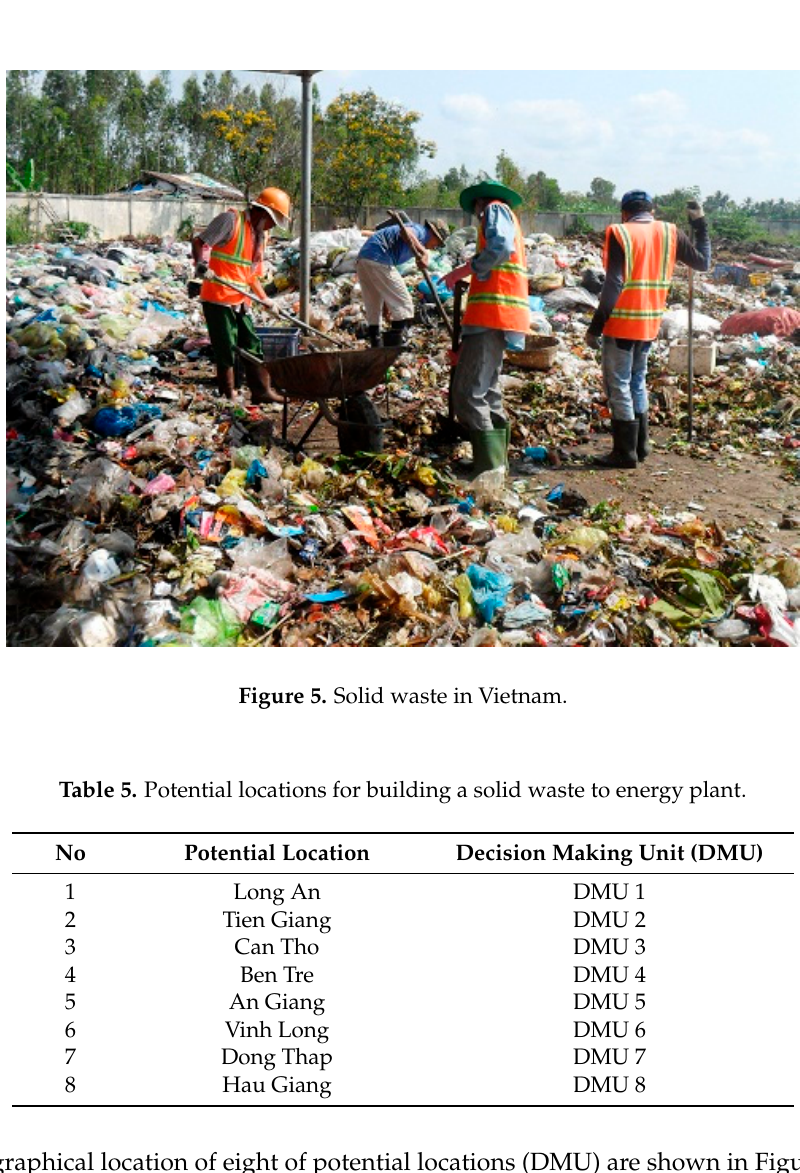
Figure 7. The hierarchical structures of the fuzzy analysis network process (FANP). A fuzzy comparison matrix for all criteria from FANP model is shown in Table 6.